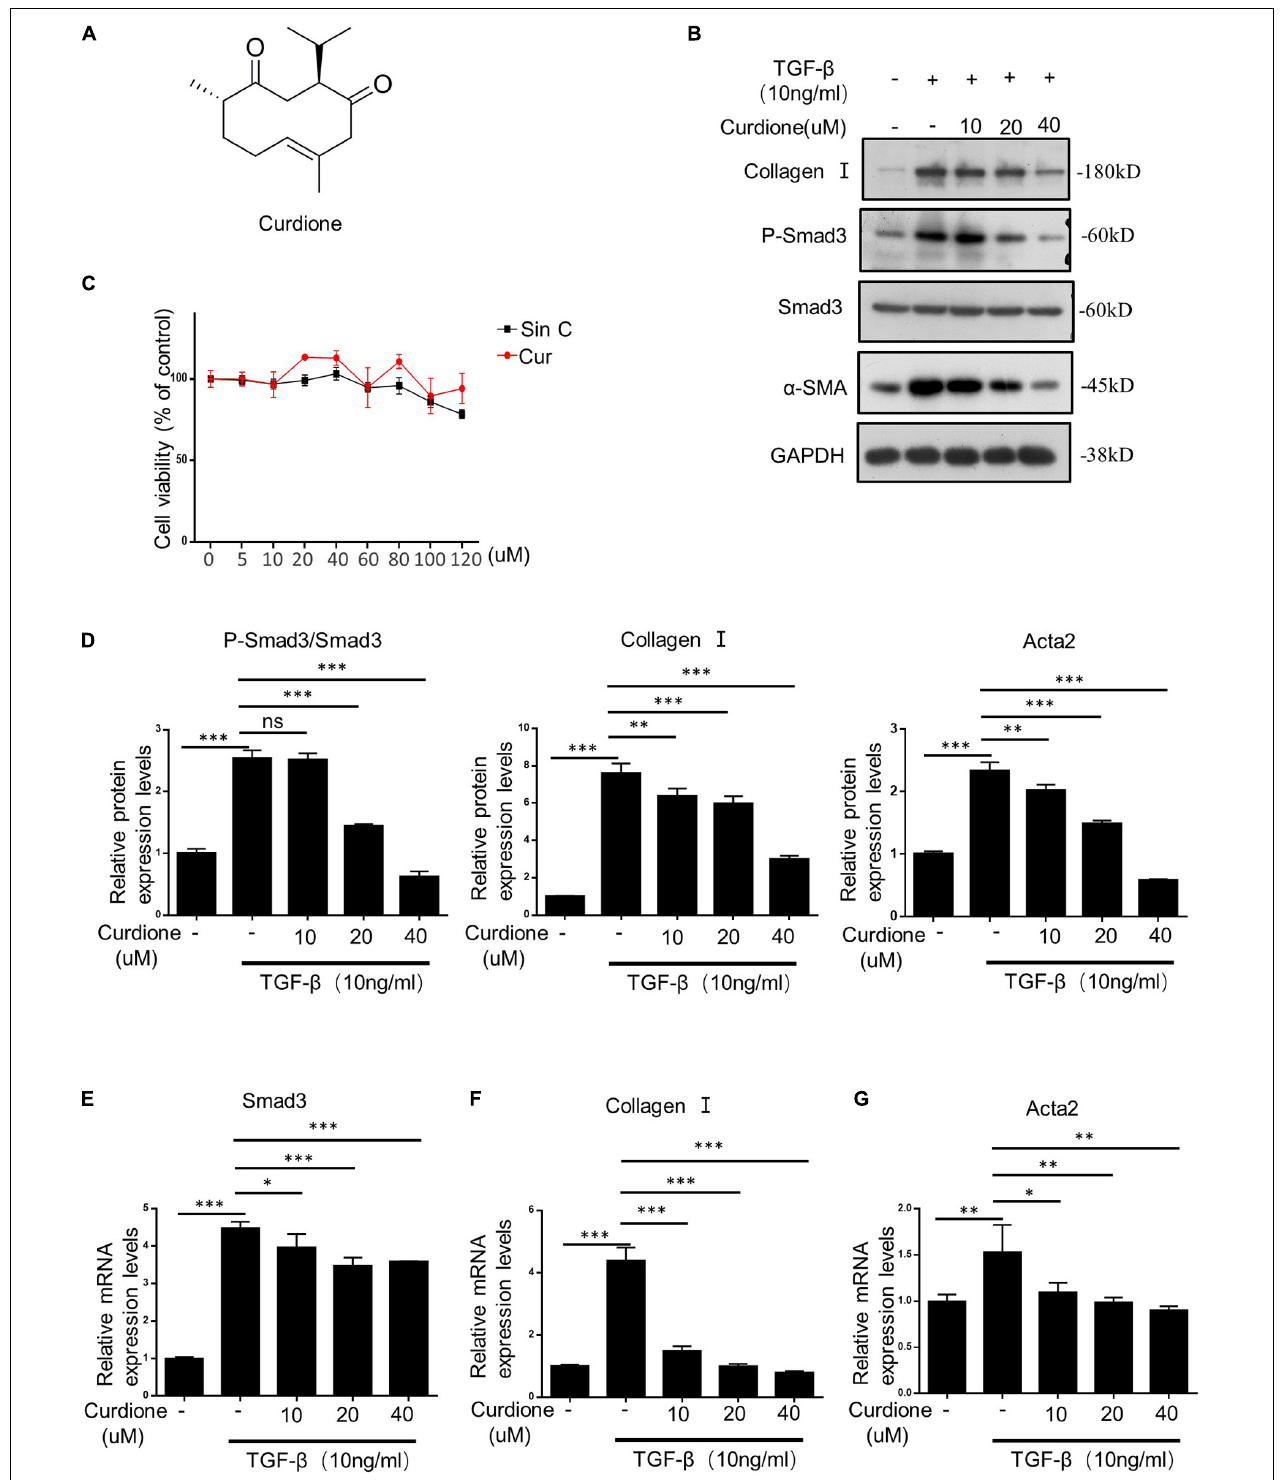
FIGURE 3 | Curdione inhibits TGF- β 1/Smad-mediated activation of hepatic stellate cells (HSCs). (A) Structure of Curdione. (C) The Cell viability of LX-2 cells treated with different concentrations of SinC and Curdione was determined using CCK-8 kit. LX-2 cells treated with Curdione (10, 20, and 40 µ M) and then stimulated with TGF- β 1 (10 ng/ml), the protein of Collagen I, α -SMA, Smad3, p-Smad3, GAPDH were detected by Western blot analysis (B,D) . And quantitative PCR analysis of Collagen I, α -SMA, Smad3 mRNA levels (E–G) . Data are expressed as the mean ± SD of three independent experiments in panels (C–G) , * p < 0.05, ** p < 0.01, and *** p < 0.001; ns, not